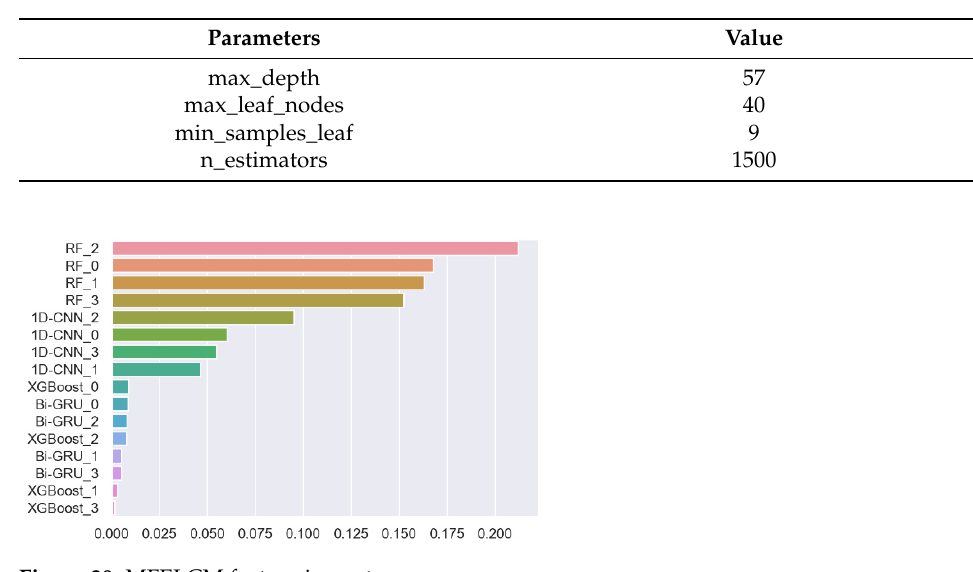
Table 13. Parameters of Random Forest2.